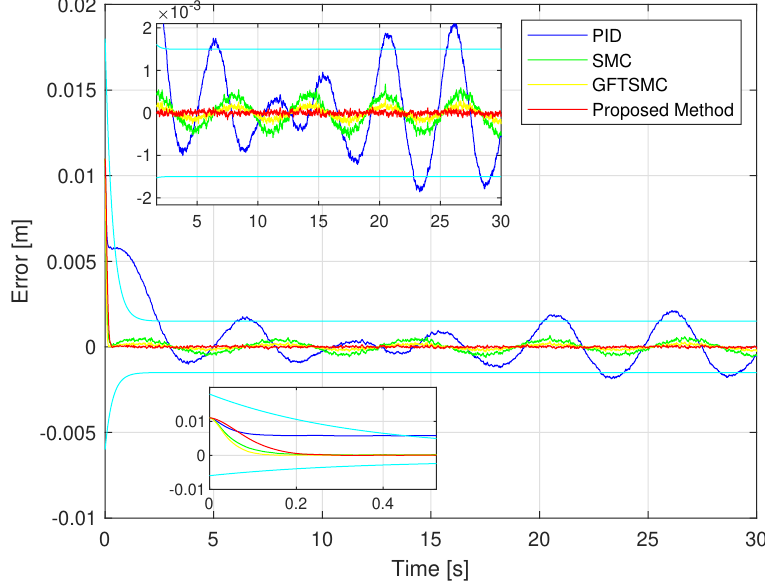
Figure 7. Time evolution of the trajectory errors of the controlled ball using four control methods. Regarding the problem of oscillations in the control voltage, all four control methods appear oscillation phenomena. Due to the influence of sensor measurement noise, even